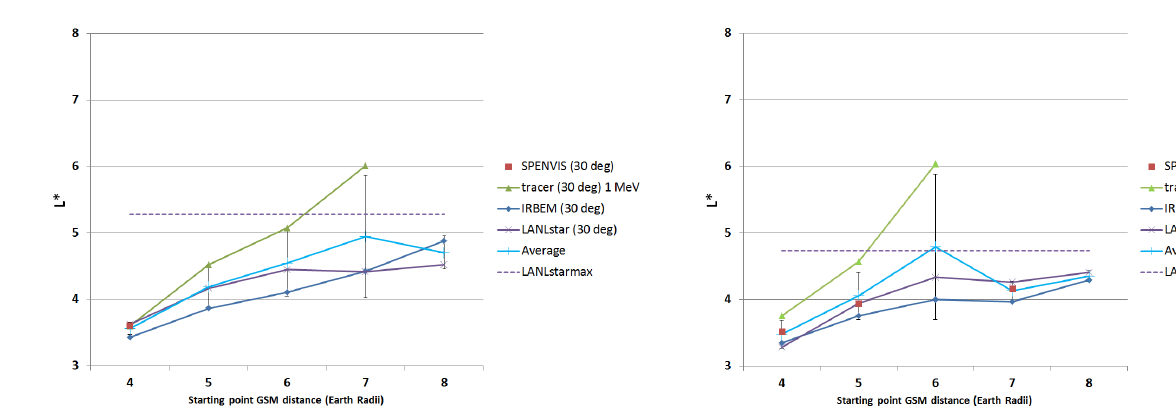
Figure 8. Calculations of L ∗ as a function of initial distance (in R E ) at 00:00MLT, for an initial pitch angle of 60 ◦ during disturbed solar wind conditions. Error bars represent the standard deviation between results from the various models.